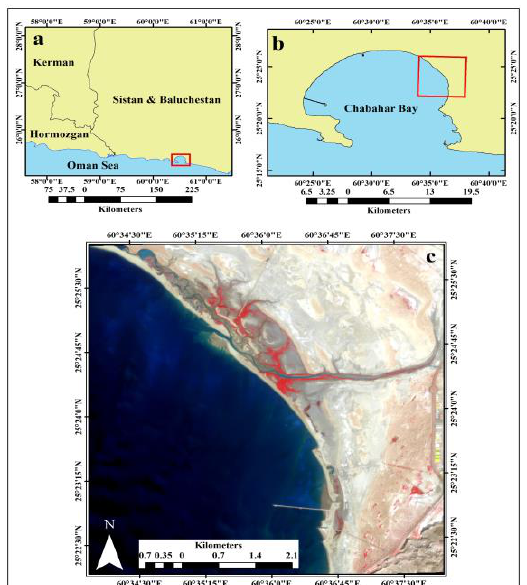
Figure 1 . The study area, Chabahar bay